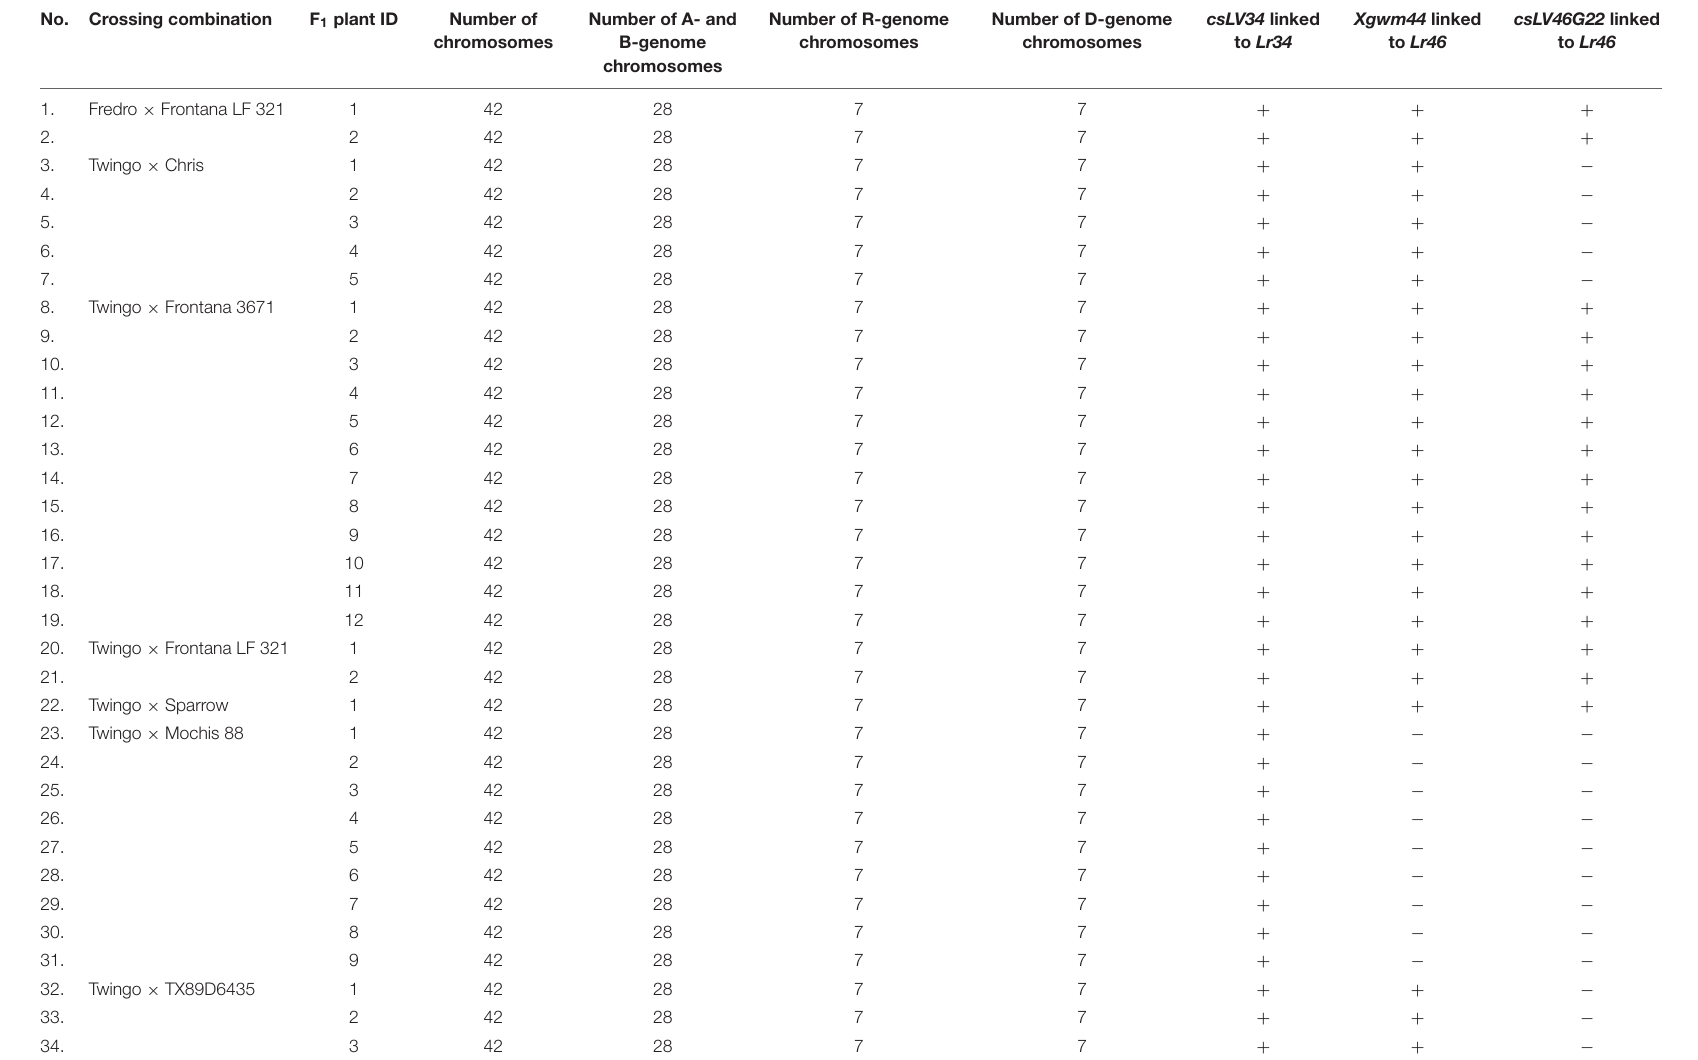
TABLE 2 | Chromosome sets of triticale × wheat hybrids and the identification of marker loci linked to slow-rusting